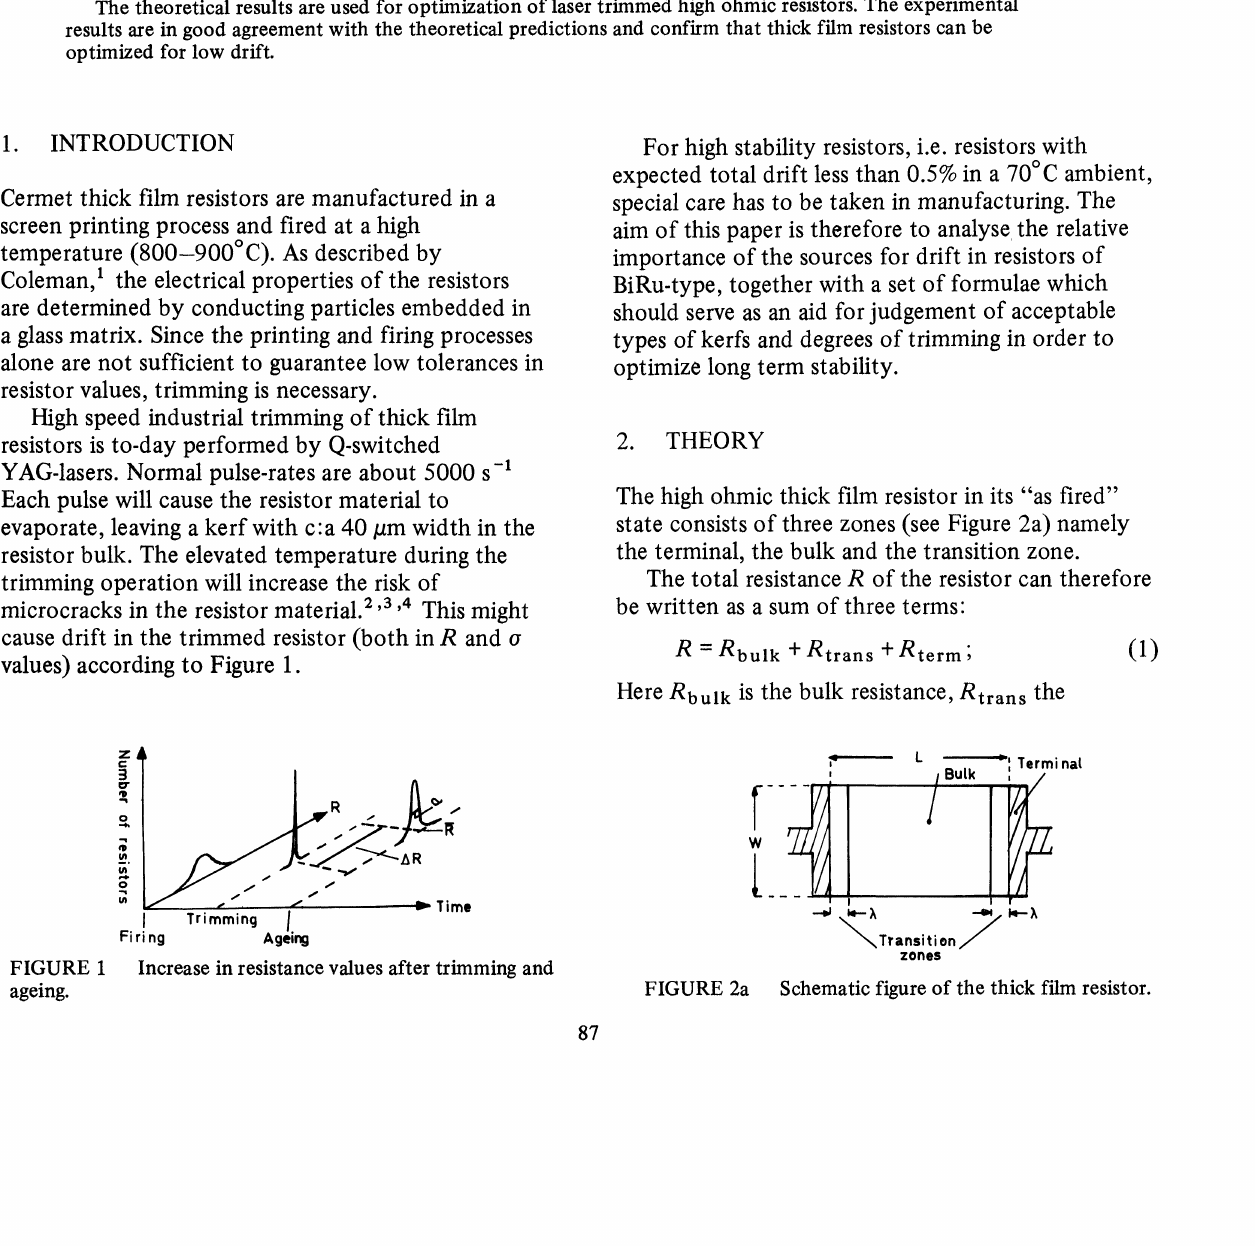
Schematic figure of the thick film